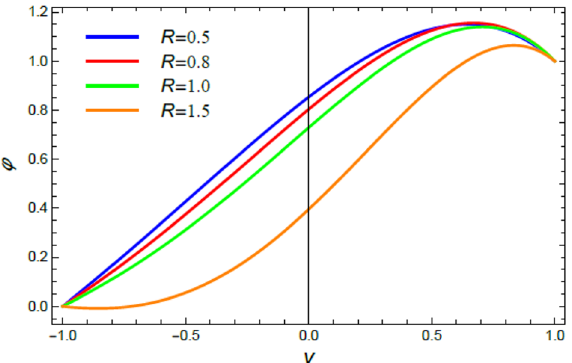
Figure 12. The nano-particles distribution φ for various amounts of the chemical reaction coefficient R .